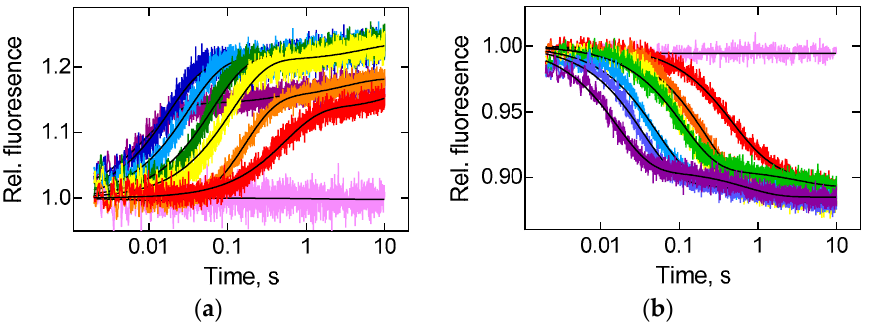
Figure 3. Temperature dependence of tRNA translocation monitored by two fluorescence labels. Time courses of translocation upon rapid mixing of pretranslocation ribosomal complex (0.06 µM) containing deacylated tRNA Met in the P site and fMet-Phe-tRNA Phe in the A site with EF-G (5 µM) from T. thermophilus at 15 ° С (red), 20 ° С (orange), 25 ° С (yellow), 30 ° С (green), 37 ° С (blue), 42 ° С (dark blue), 50 ° С (violet) or with buffer TAKM 7 at 20 ° С (pink). ( a ) Fluorescence intensity change upon movement of fMet-Phe-tRNA Phe (Prf16/17) labelled at the elbow region of tRNA. ( b ) Fluorescence intensity change upon movement of BPY-Met-Phe-tRNA Phe labelled at CCA-end of tRNA. Double-exponential fits are black lines, and numerical values are provided in Figure 4 and Table 1. Each time course reflects the average of 5 to 7 technical replicates. S.e.m. associated with the kinetics were calculated by the GraphPad Prism software. Table 1. Temperature dependence of rate constants of tRNA translocation.